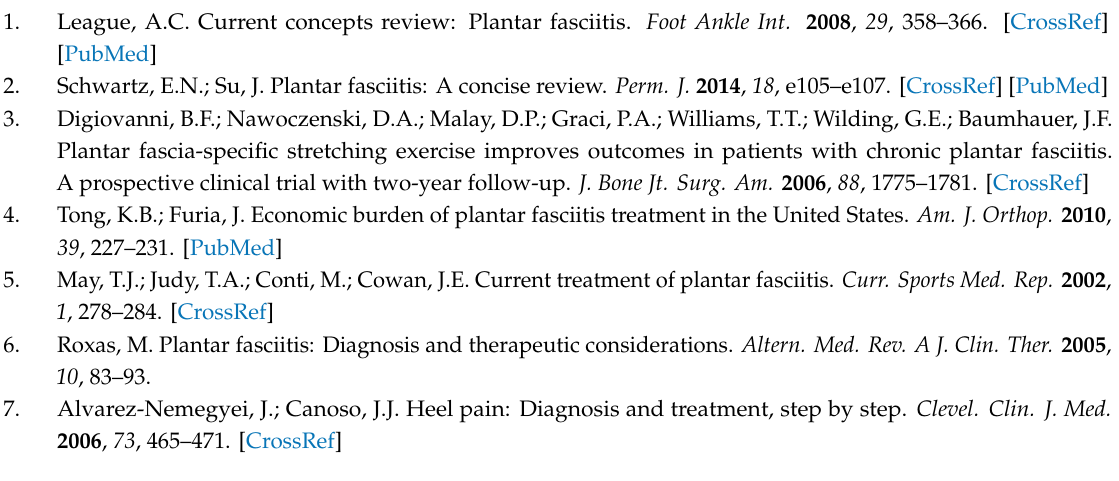
Figure S1: Home based plantar fascia stretching exercises, Table S1: Home based plantar fascia stretching exercises log. Plantar Fascia stretching exercises